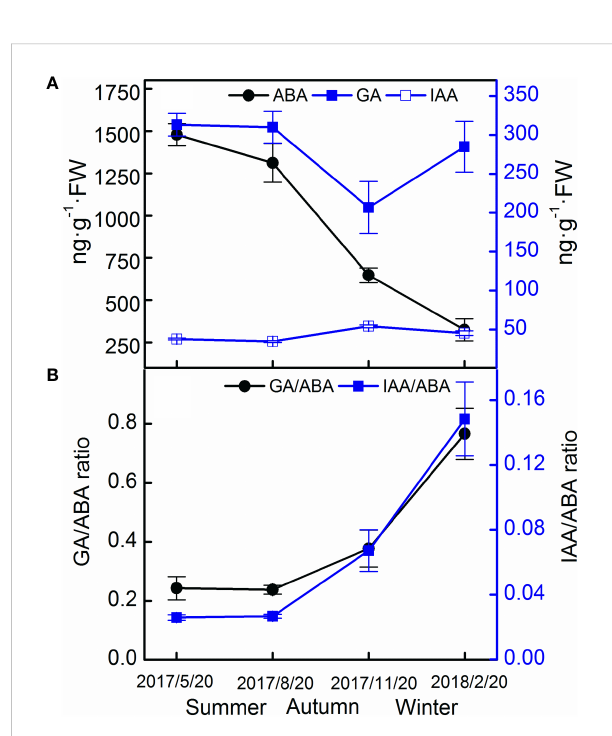
FIGURE 7 Endogenous hormone contents (A) and their ratios (B) of Taxus chinensis var. mairei seeds in the fi eld experiment. The vertical bars represent standard errors of the mean (n = 3).